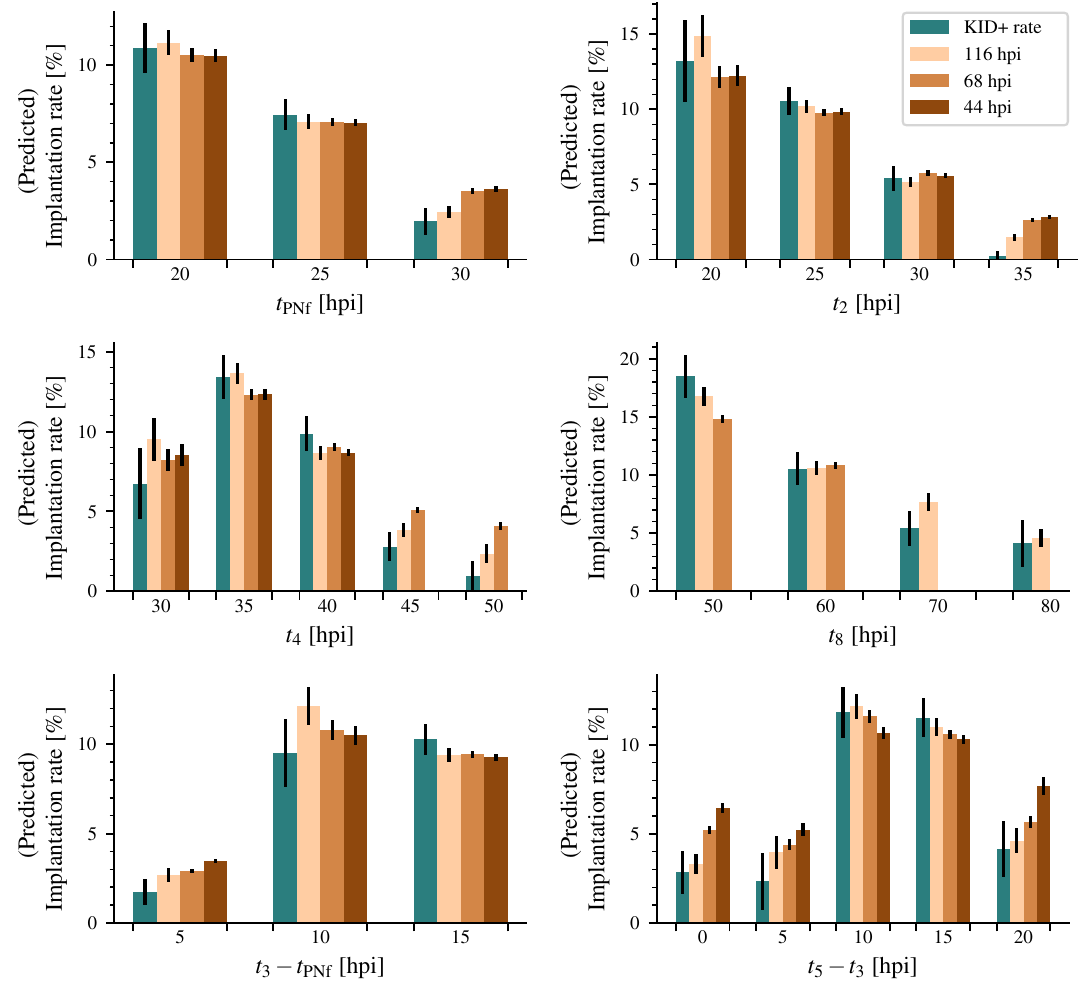
Figure 5. Evaluation of biological explainability of iDAScore v2.0 that shows a comparison between the estimated implantation likelihood (KID+ rate) for embryos with similar morphokinetic parameters and their predicted implantation rate at 116 hpi, 68 hpi, and 44 hpi. The evaluation uses the day 5+ test set with an assumption that deselected embryos have an implantation likelihood of 0%. The bars denote the 95% confidence interval. There is a good concordance between the predicted implantation rate and the actual implantation rate with slight overestimation at the